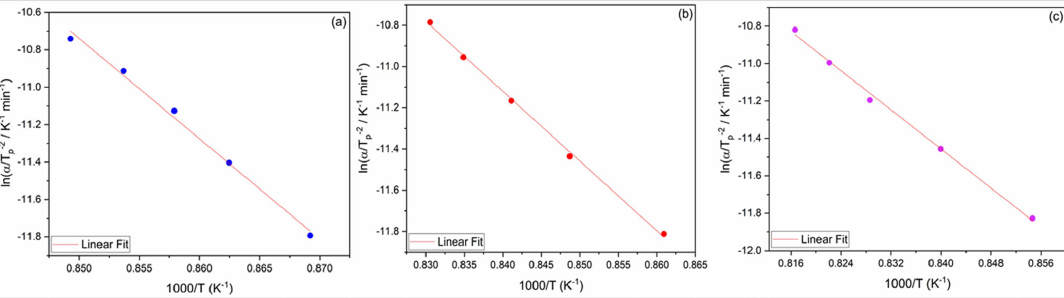
Figure 11. Kissinger plots: Determination of the activation energies obtained from the crystallization peak in Ca Glass. (a) Curve 1, (b) Curve 2 and (c) Curve 3. wollastonite as the main phase (~ 262 kJ/mol calculated by assign the calculated energy for Phase 3, 446 kJ/mol, to KM 64 ). It was not possible to find values for the activation CaTiSiO . Therefore, from the KM, it is concluded that the 5 energy of glass-ceramics with the CaTiSiO phase. However, average activation energy for obtaining the glass-ceramics 5 according to the reported high theoretical enthalpy of formation of this phase (~ 2601 kJ/mol 65 ), it is possible to